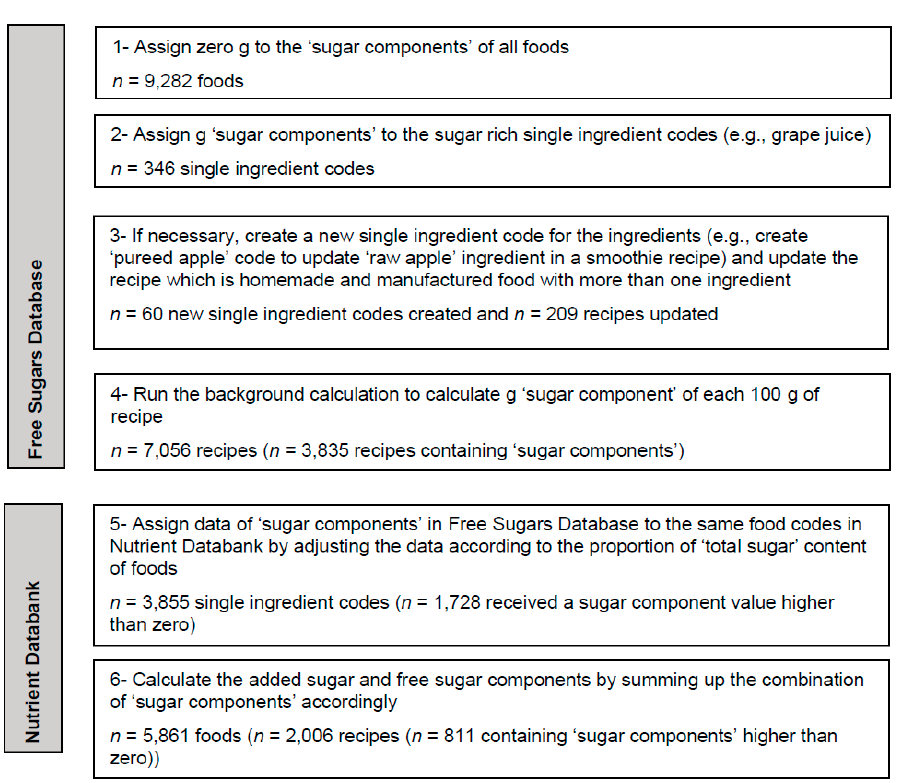
Figure 2. The steps for the estimations of added sugars and free sugars content of foods in the Nutrient Databank for reporting free sugars intake in the United Kingdom National Diet and Nutrition Survey (UK NDNS).